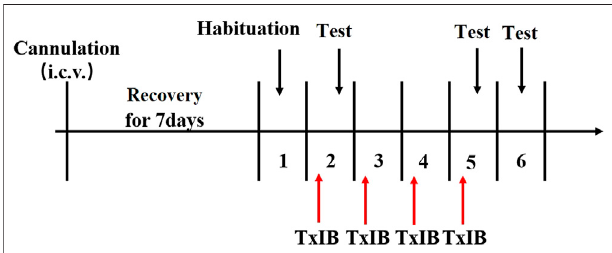
FIGURE 3 | Schematic diagram of the experiment of locomotor activity and elevated plus maze